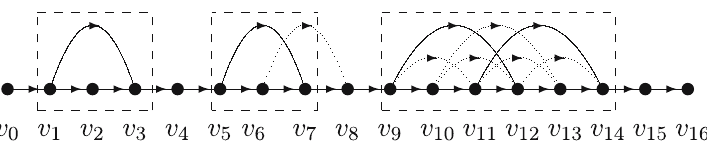
Figure 2: The vertex set partition of a round purely local tournament D which is non - strong. ( ) = ⋃ ,